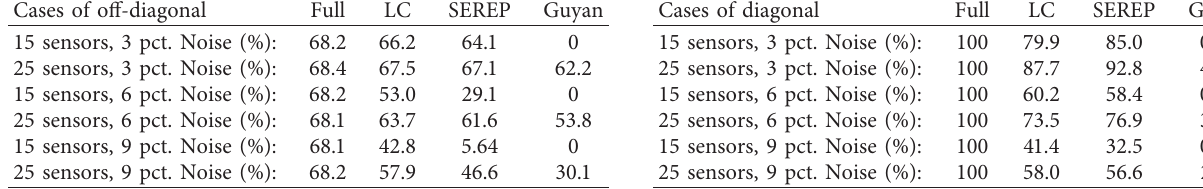
Table 3: The percentage of simulation results where the lowest diagonal element in the XOR matrices stays above the threshold of 0.95. Cases of